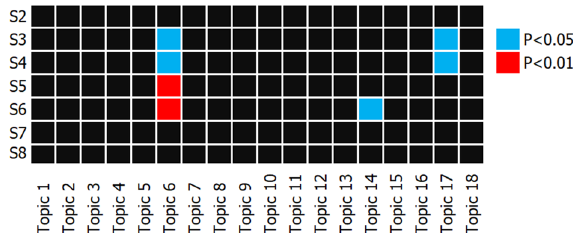
Figure 2. Heatmap of the associations between all topics and polygenic risk score (PRS) tranches of autism spectrum disorder (ASD). Topics were inverse-normal transformed prior to linear regression modelling with age, sex, and first five genetic principle components included as predictors. The figure shows that associations between the topics (i.e., clusters of comorbid conditions) and PRS tranches indicating polygenic loads for ASD. Topic 6 is over-represented by terms relating to allergies while Topic 17 is over-represented by sensory processing issues.